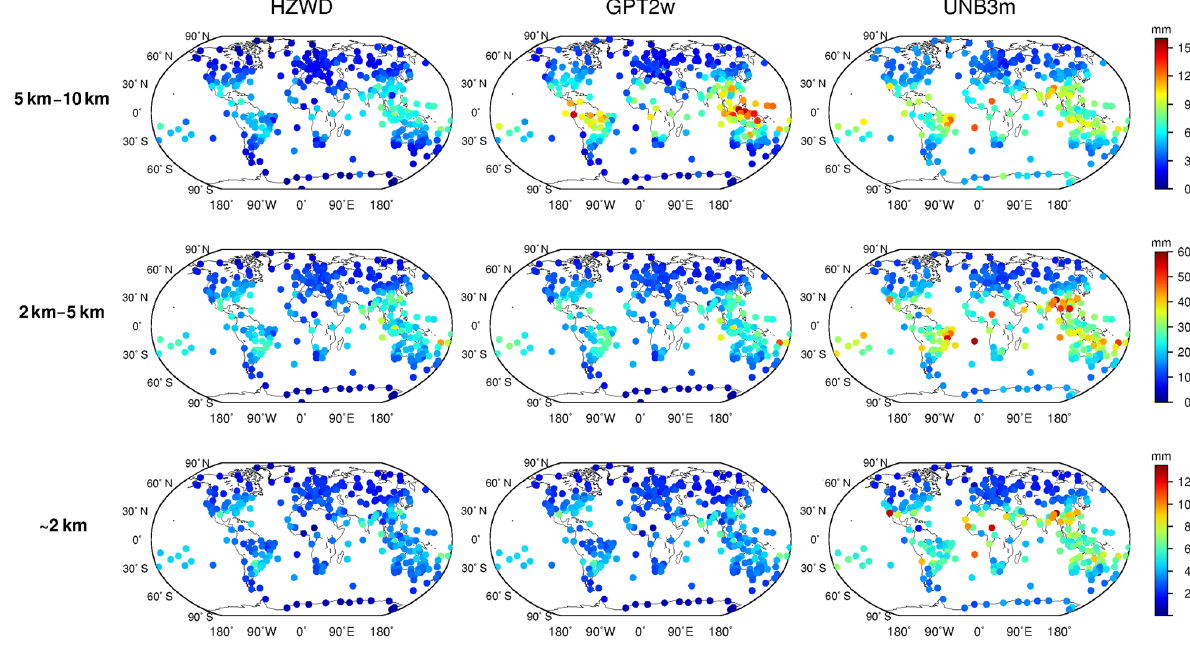
noting that the bias and RMSE of the HZWD model and the GPT2w model are both larger than those of the results from ECMWF data in Table 2. The reason is that the HZWD